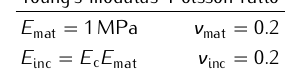
Table 1. Young’s modulus and Poisson ratio of matrix material and inclusions